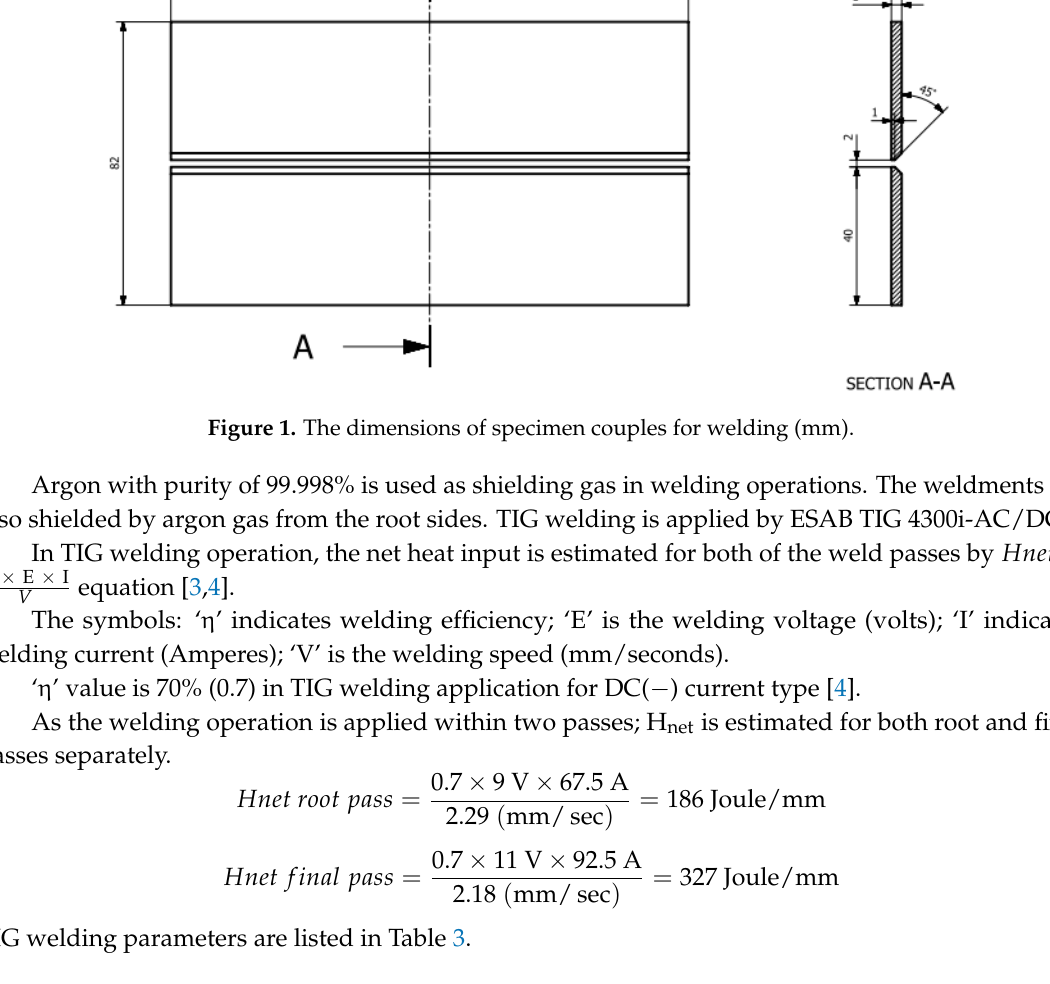
Table 3. TIG welding parameters.